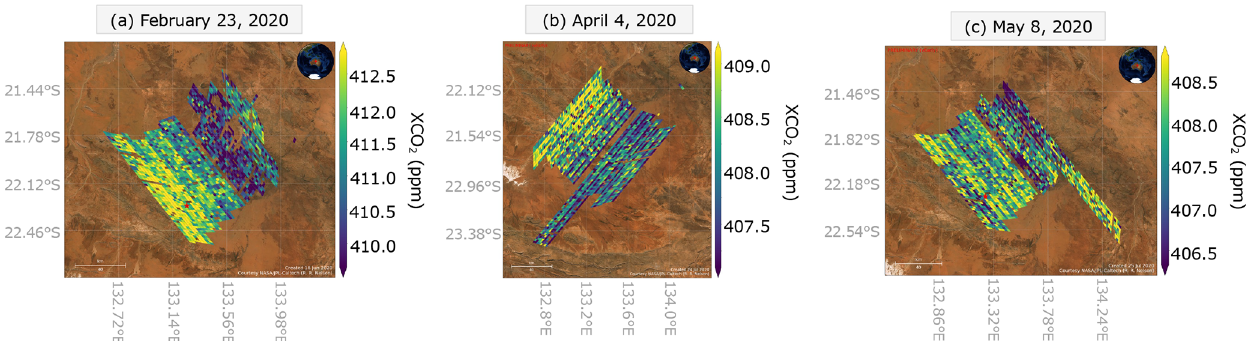
Figure 10. Three OCO-3 vEarly SAMs, shown with no filtering or bias correction, all over the same ecostress_au_asm observation site. These three SAMs were chosen for simulation tests due to their varying degrees of apparent SB, as well as different observation and solar geometries.